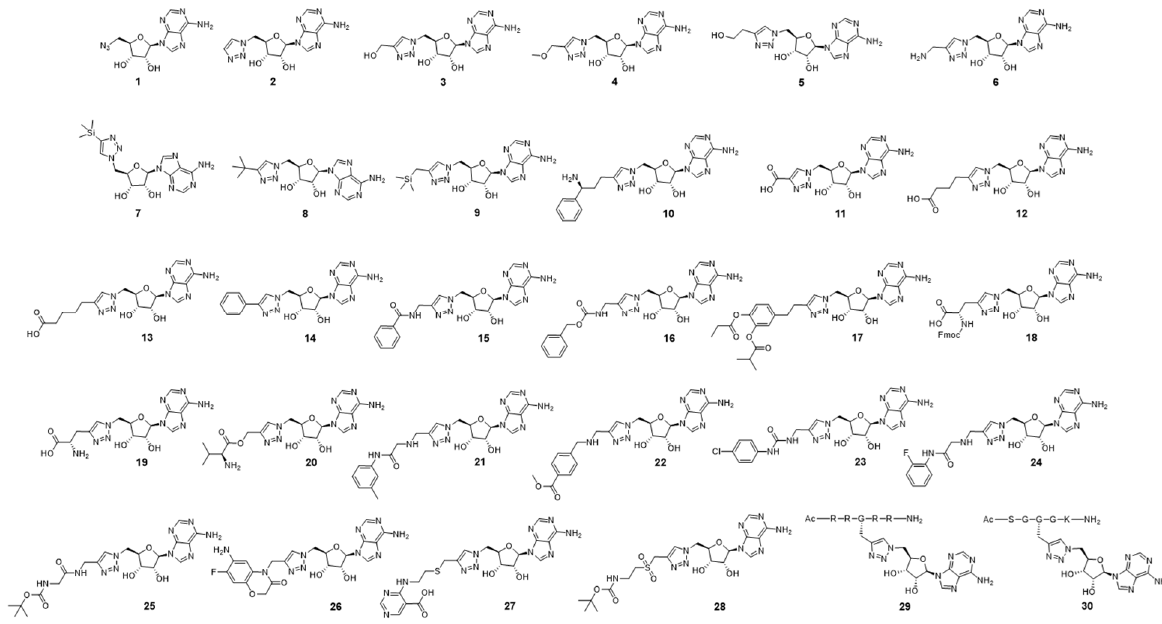
Figure 4. Synthesized triazole containing adenosine